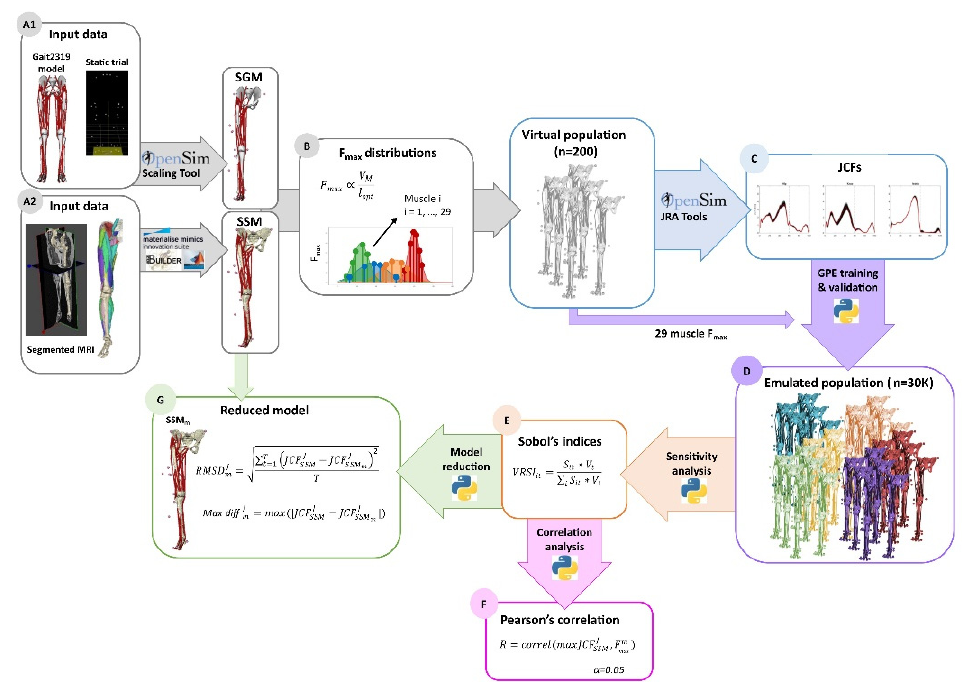
Figure 1. Workflow of the study. From top left clockwise, ( A1 ) literature Gait2392 model is scaled in OpenSim using a static standing trial to obtain a scaled-generic model (SGM) while ( A2 ) MRI segmentation is used to generate a subject-specific model; ( B ) literature F max values from 29 lower- limb muscles are used to estimate distributions of F max across a virtual population ( n = 200); ( C ) joint contact forces (JCF) are estimated for hip, knee and ankle and input to the Gaussian Process emulator (GP) together with associated F max values for training and validation; ( D ) JCF waveforms are emulated ( n = 30 K) to conduct ( E ) a Sobol’s sensitivity analysis, whose results are then used to inform model reduction strategy; ( F ) Pearson’s correlation between JCF and F max of most influential muscles is assessed; ( G ) the reduced model is compared, through RMSD and absolute maximum difference, to the nominal, fully personalised model.